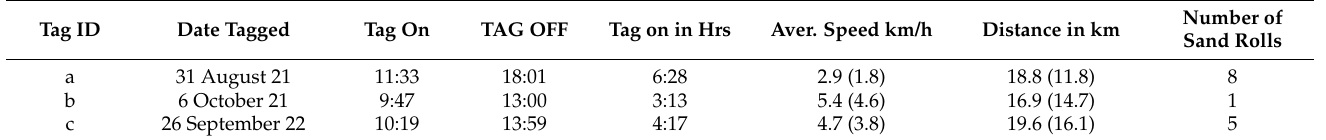
Table 1. Overview of three tag deployments for which sand rolling was identified. All tags were deployed near the dorsal fin facing forward. The estimate distance and average speed based on start and end of deployment shown in